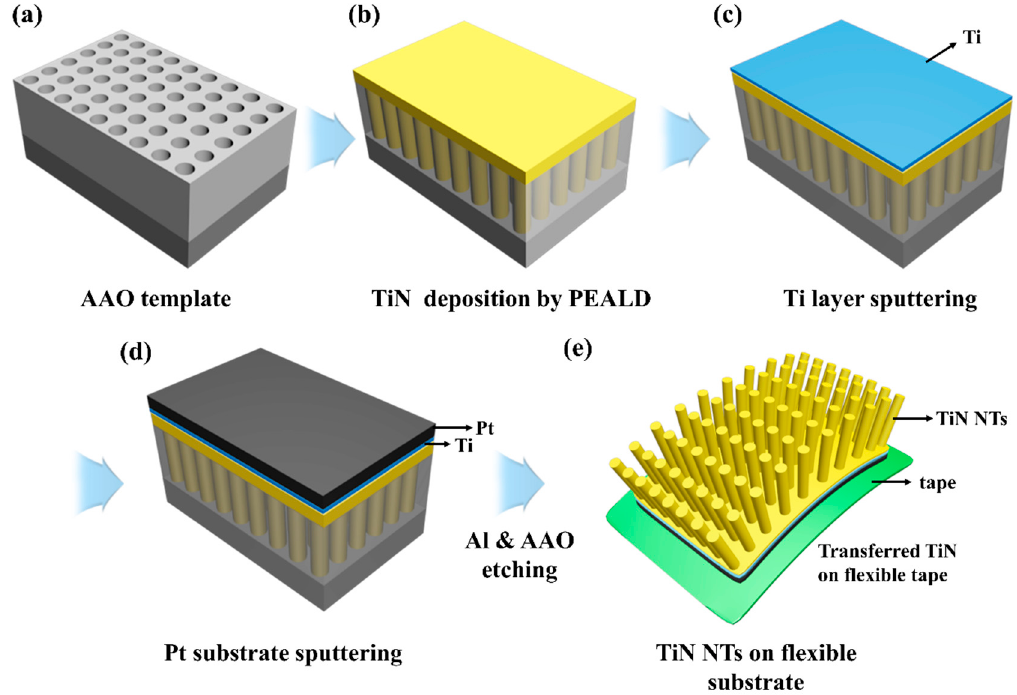
Figure 1. ( a ) A schematic illustration of the preparation of flexible TiN nanotube arrays. ( a ) anodized aluminum oxide (AAO) template, ( b ) deposition of TiN on the AAO by plasma enhanced atomic layer deposition (PEALD), ( c ) Ti, ( d ) Pt layer sputtered onto the top of deposited TiN, ( e ) TiN nanotubes (NTs) on a flexible substrate after removing the AAO template.